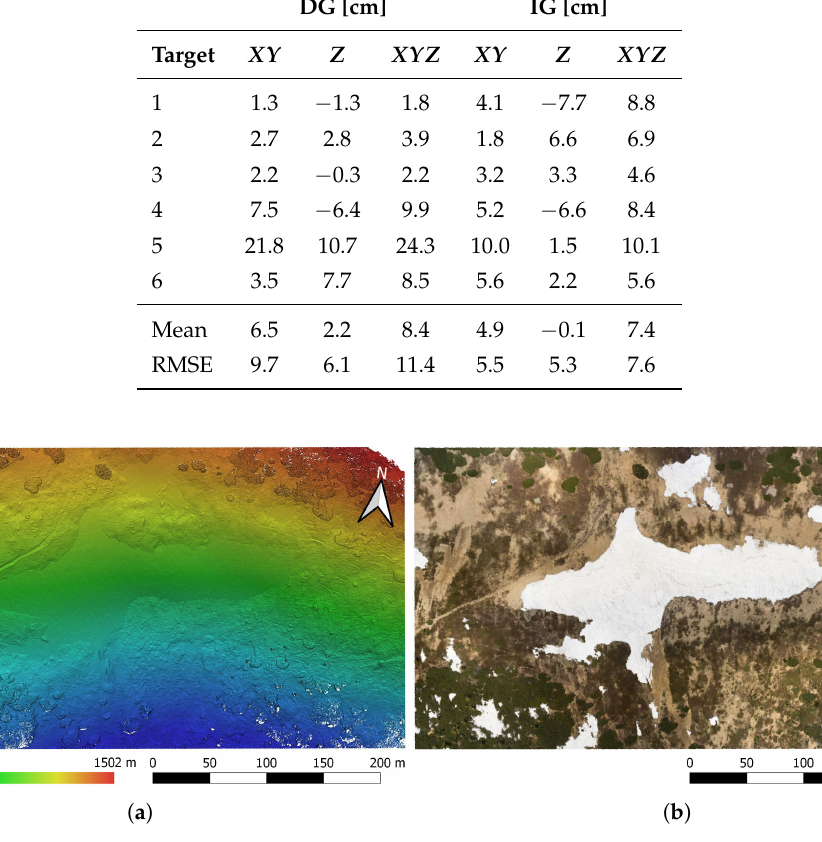
Figure 12. The directly georeferenced, shaded DEM ( a ) and the relevant orthophoto ( b ), both representing the output of the photogrammetric processing